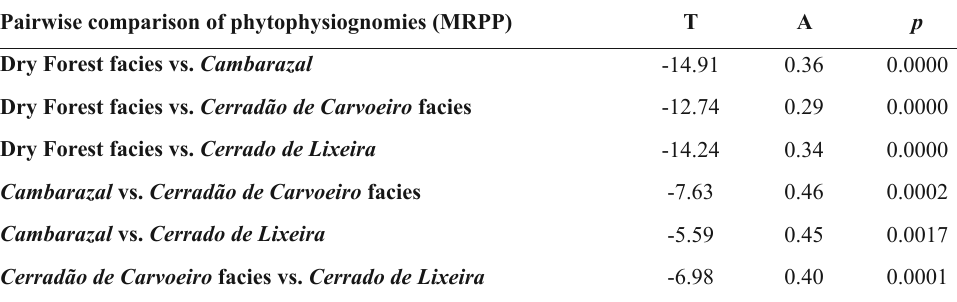
Summary statistics for pairwise comparison (MRPP) among the studied phytophysiognomies along a soil moisture and fl ood gradient in RPPN SESC Pantanal, Brazilian Pantanal. T = degree of separation between the groups, higher negative values indicating greater separation A = level of within-group agreement, comparing the distance within and between the groups, higher values indicating greater